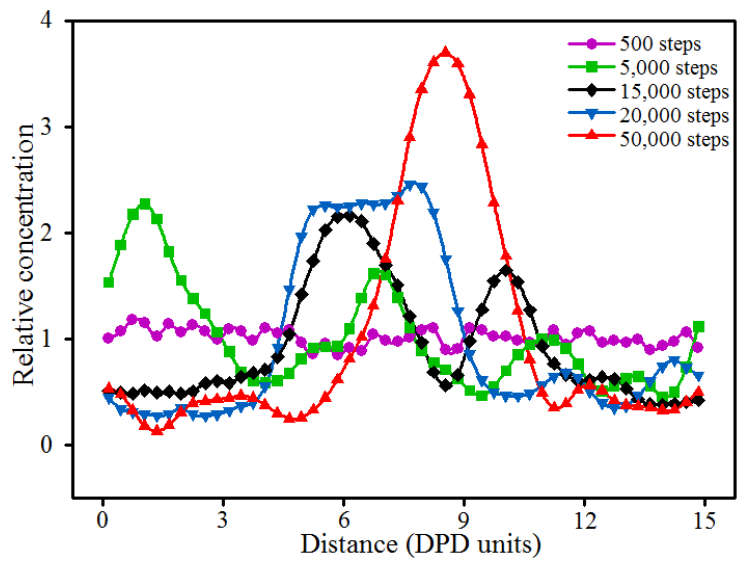
Figure 3. Dynamics process of the aggregation of nano-silica in the 10% PVA/10% PAM/2% nano- silica blended hydrogel system: ( a ) 500 steps; ( b ) 5000 steps; ( c ) 15,000 steps; ( d ) 20,000 steps; ( e ) 50,000 steps; and ( f ) equilibrium model with all beads shown at 50,000 steps. The red, blue and yellow denote PVA, PAM and nano-silica, respectively; and for the rest, dark green denotes water.